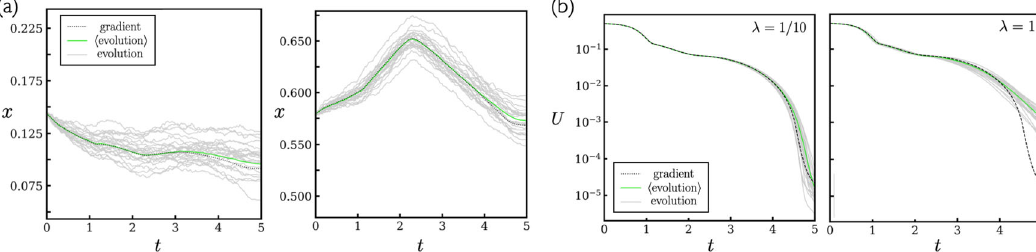
Fig. 3 As Fig. 1, now for a deep neural network with eight hidden layers. Panel a shows 2 of the 7489 parameters of the network. Panel b shows the loss, for two different neuroevolution step-size parameters [see